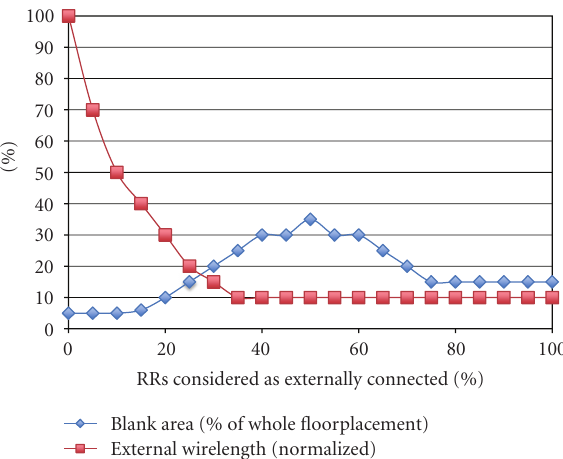
Figure 5: Example of wirelength reduction (normalized) and blank area left (percentage of the final floorplacement) for the floorplacement of only externally connected RRs plotted with respect to the percentage of RRs that are considered as externally connected by the